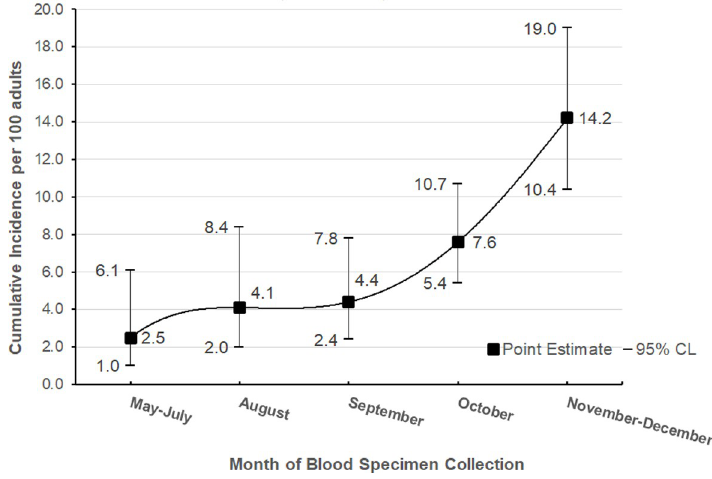
Fig 1. Prevalence of SARS-CoV-2 infection in adults by date of collection, Arkansas, May—December